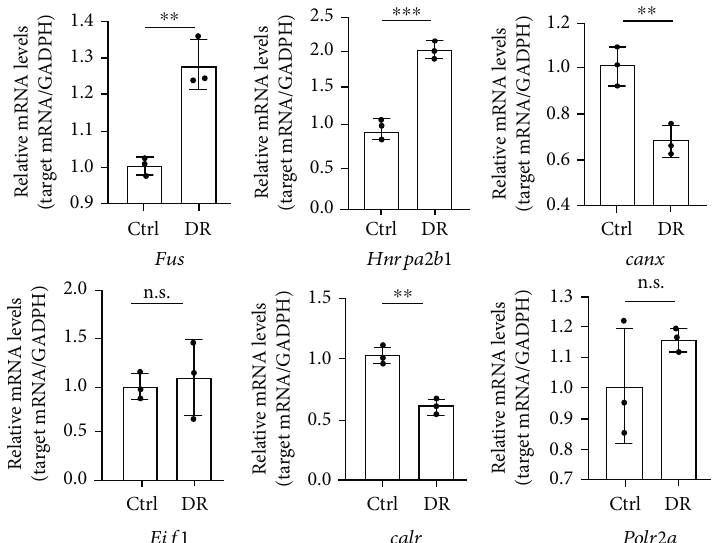
Figure 5: qRT-PCRs were conducted to detect 6 di ff erently expressed genes in mouse retinas ( n = 3 ) after diabetes mellitus induction. GAPDH was detected as the internal control. Data are expressed as mean ± SD . ∗ p < 0 : 05 , ∗∗ p < 0 : 01 , and ∗∗∗ p < 0 : 001 , n.s.: not signi fi cant, by 2-tailed Student ’ s t